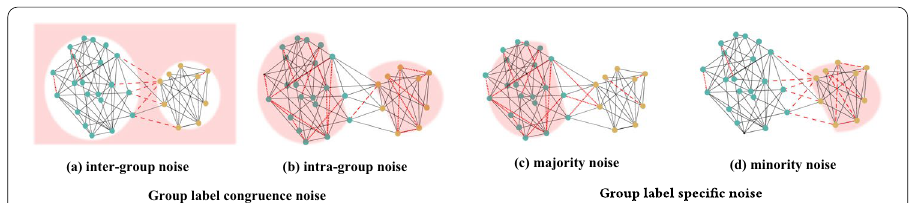
Fig. 2 Schematic representation of node attribute-based noise. We visualize the four different cases for node attribute-based noise for a homophilic network. In a , b we can see the two cases of group label congruence noise, inter-group noise on the left and intra-group noise on the right. In c , d we illustrate group label specific noise. If we define the majority as the specific group of interest, we can see majority affiliated noise on the left and minority affiliated noise on the right. Note that here we only show homophilic networks while we also consider neutral/heterophilic networks in our experiments